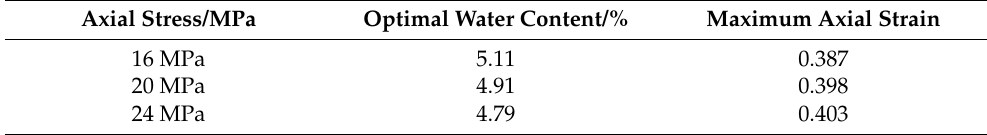
Table 3. Fitting results of the relationship between axial strain and water